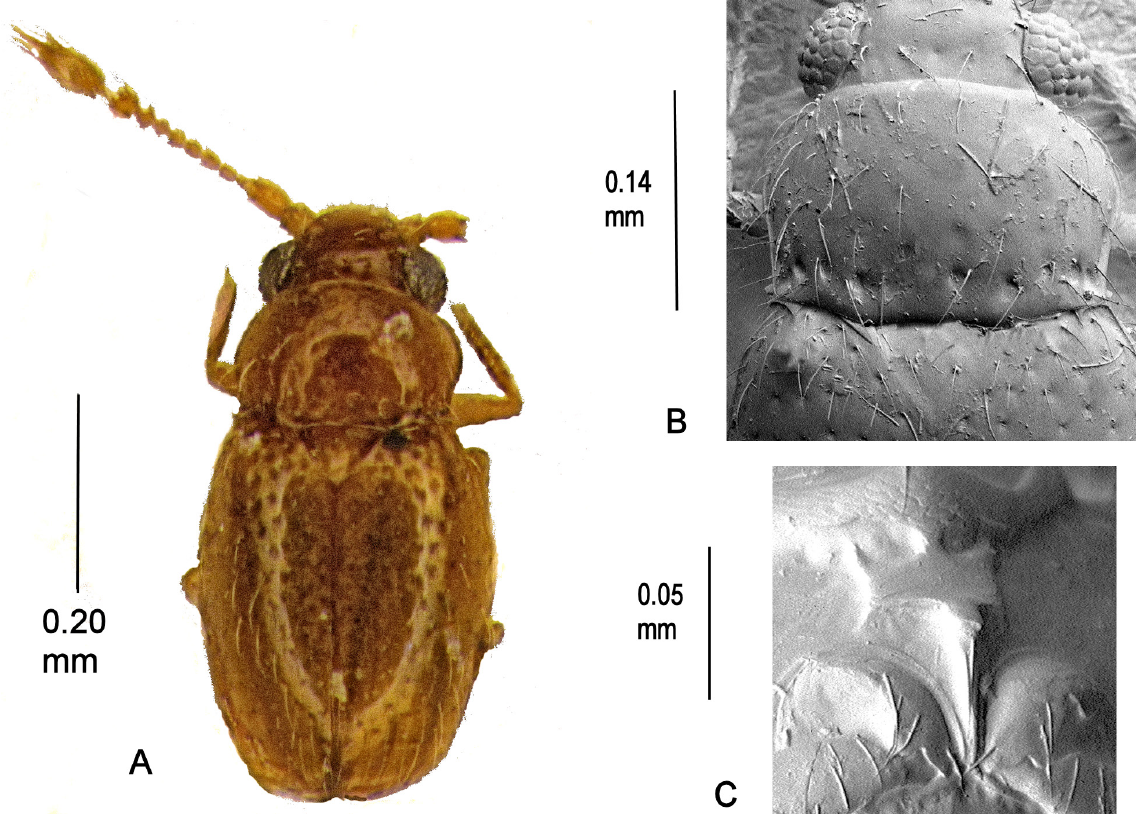
Fig. 21 . Cissidium davaoense sp. nov. A . Habitus. B . Pronotum, × 870. C . Mesoventrite showing median process of collar, mid-keel and keel, ×